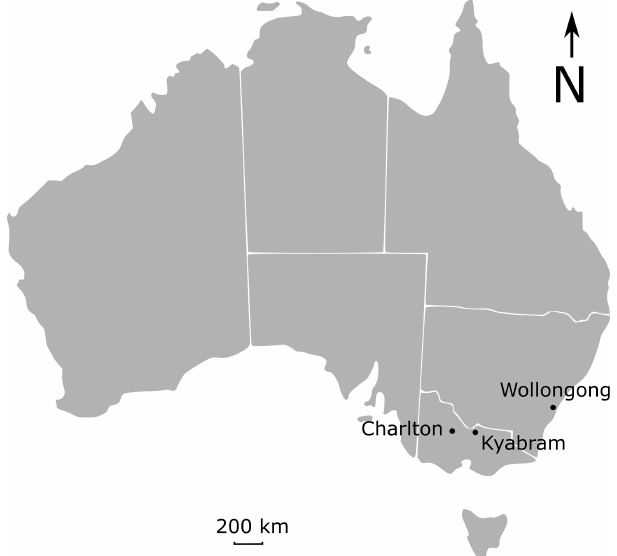
Figure 1. Three experimental sites at Wollongong sports field, Kyabram research centre, and a feedlot at Charlton.